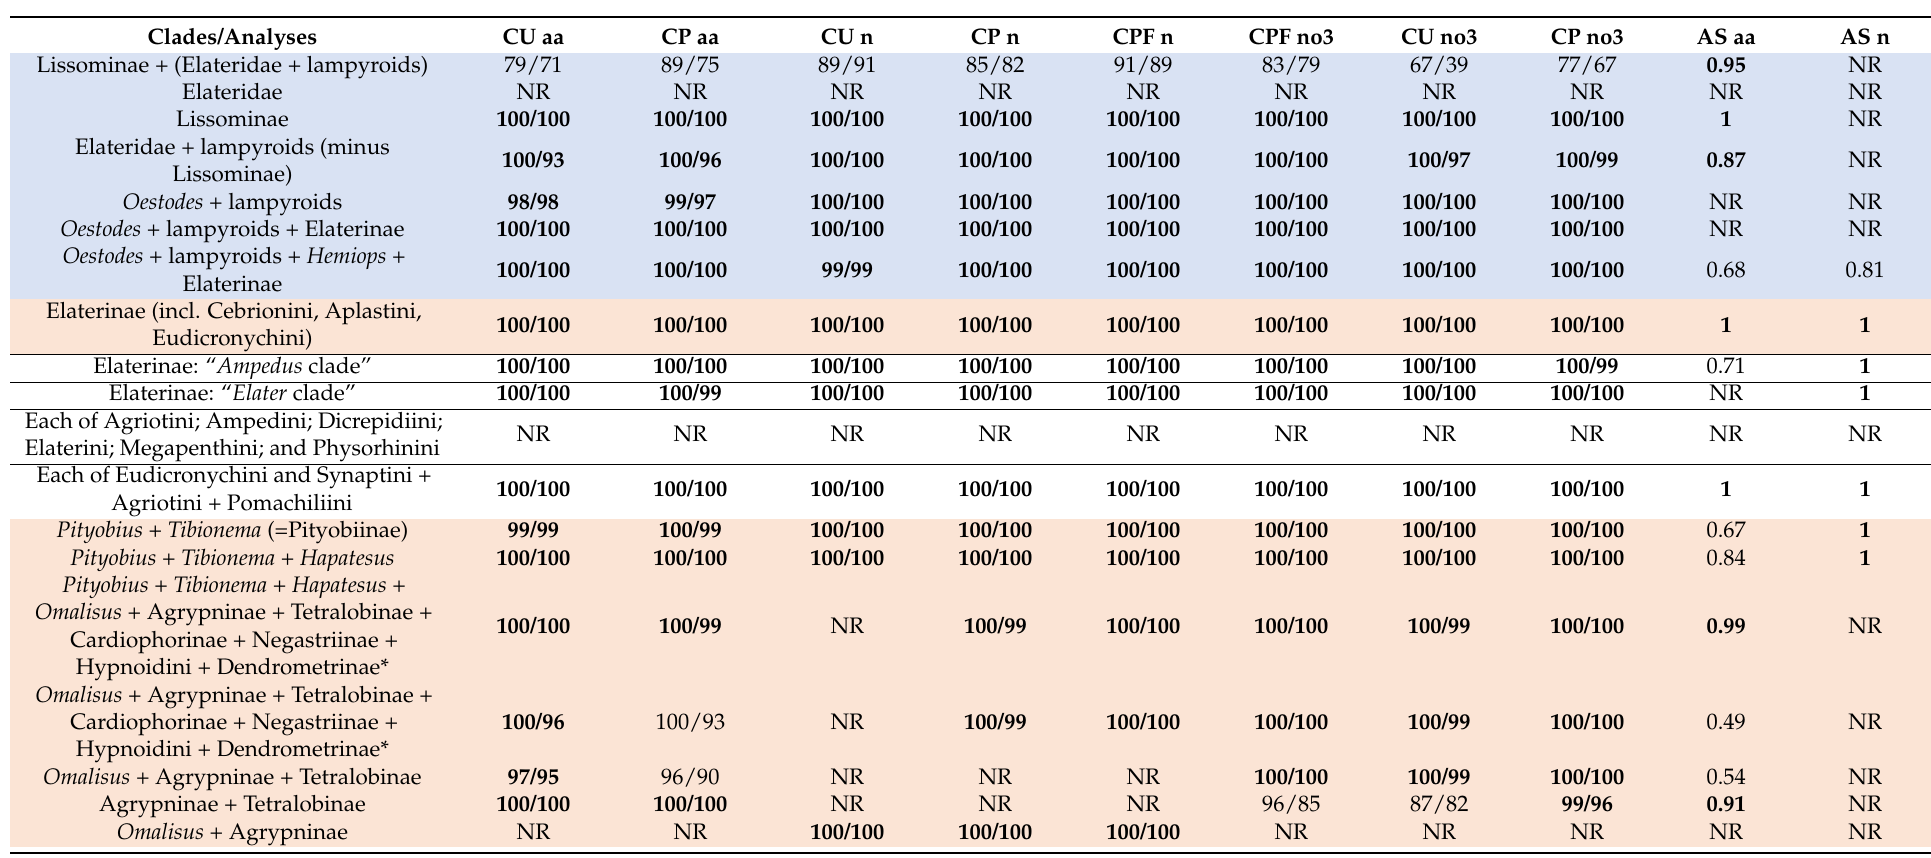
Table 1. Support for clades in analyses of 50% completeness matrices. Support format is UFB/SHT for concatenated analyses and LPP alone for coalescent analyses (two rightmost columns). Results indicating strongly supported clades are bolded. Clades that include members of multiple families are highlighted blue, and clades with members of multiple elaterid subfamilies are in orange. Strengths and weaknesses of individual analyses are treated in the discussion. C = concatenated; AS = ASTRAL (coalescent); U = unpartitioned; P = partitioned; F = with flanking regions added; no3 = third codon positions omitted; n = nucleotide data; aa= amino acid data; NR = clade not recovered. Dendrometrinae* = incl. Oxynopterini, Plastocerus , Dimini, Dendrometrini, Semiotini, Prosternini, and